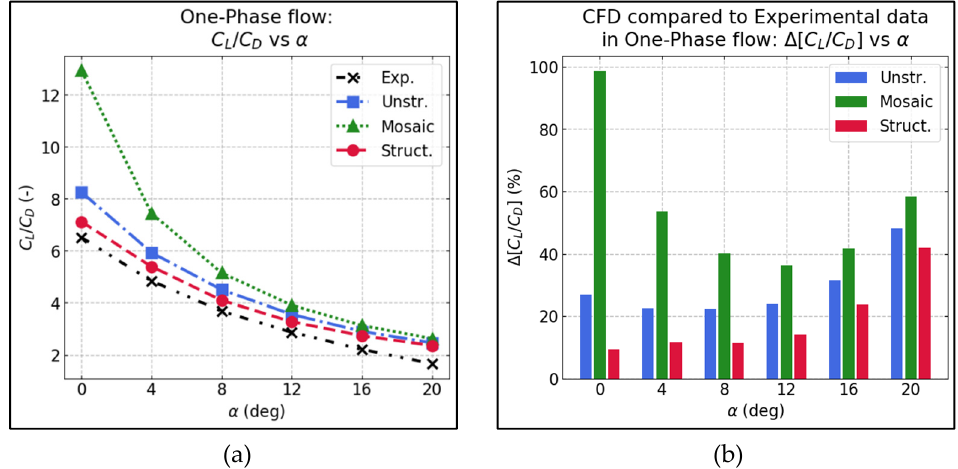
Figure 11. ( a ) Aerodynamic efficiency of wing from numerical simulations under 3 different meshes and experiment ( b ) Deviation of aerodynamic efficiency from simulations compared to experimental results (single phase).